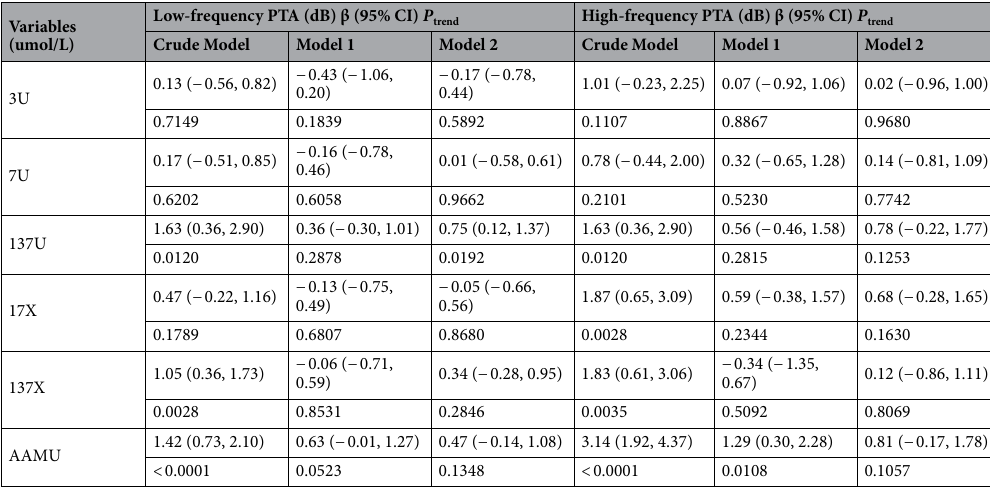
Table 3. Association between urinary caffeine metabolites and hearing threshold at low and high frequencies. Crude Model = unadjusted. Model 1 = Crude Model + sex, age. Model 2 = Model 1 + education level, firearm noise exposure, occupational noise exposure, recreational noise exposure, cotinine, BMI, diabetes,